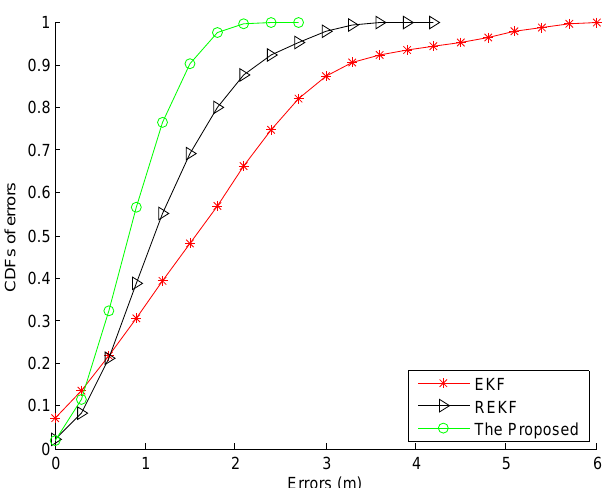
Figure 25. CDFs of errors by using the proposed fusion, EKF, and REKF systems. Table 3. Statistical errors of the proposed fusion, PBL, and WBL systems.